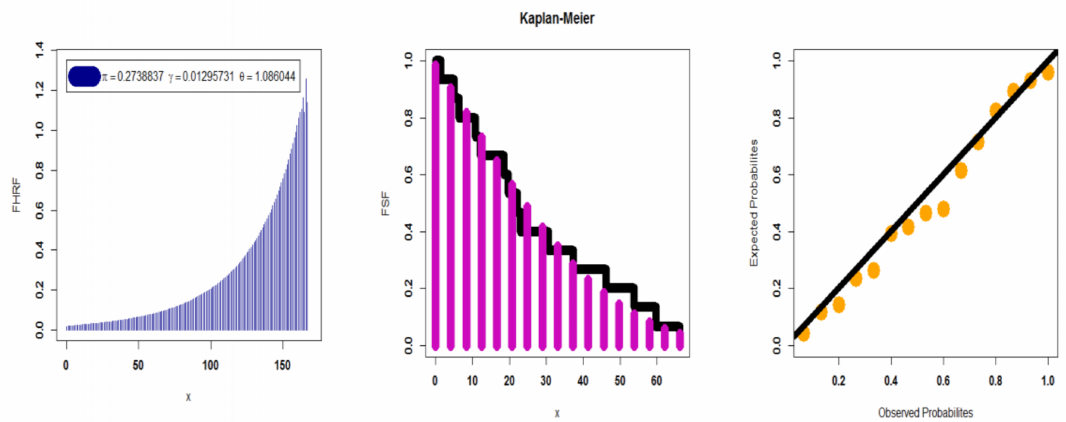
Figure 10. The FHRF, ESF, and P–P plots for dataset II.